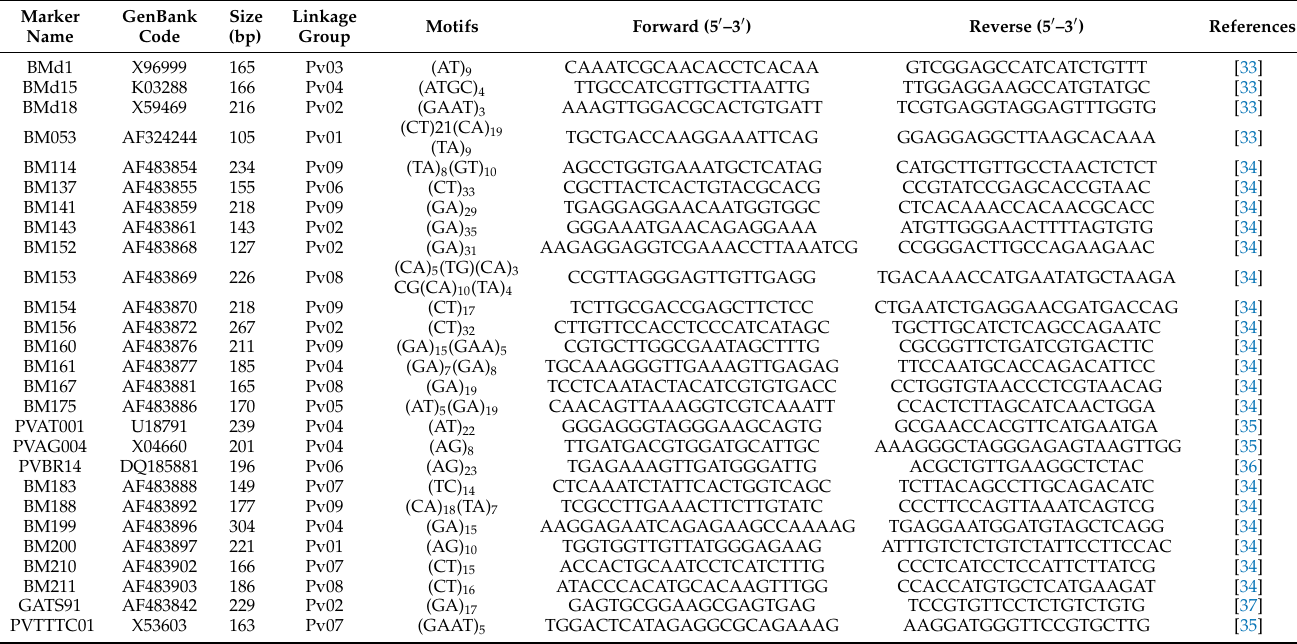
Table 2. SSR primers and sequence information used for genetic diversity analysis among bean